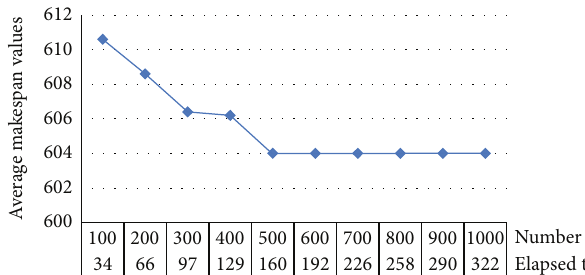
Figure 10: Average makespan values and elapsed times for the determined number of generations.